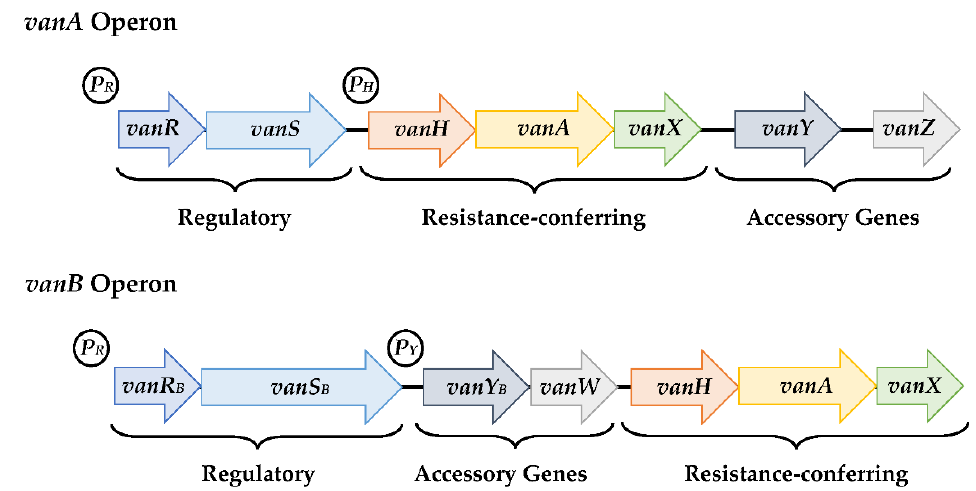
Figure 2. Representation of the organization of the vanA and vanB operons. PR, PH, PY: promoting regions. Adapted from [8,151,153].